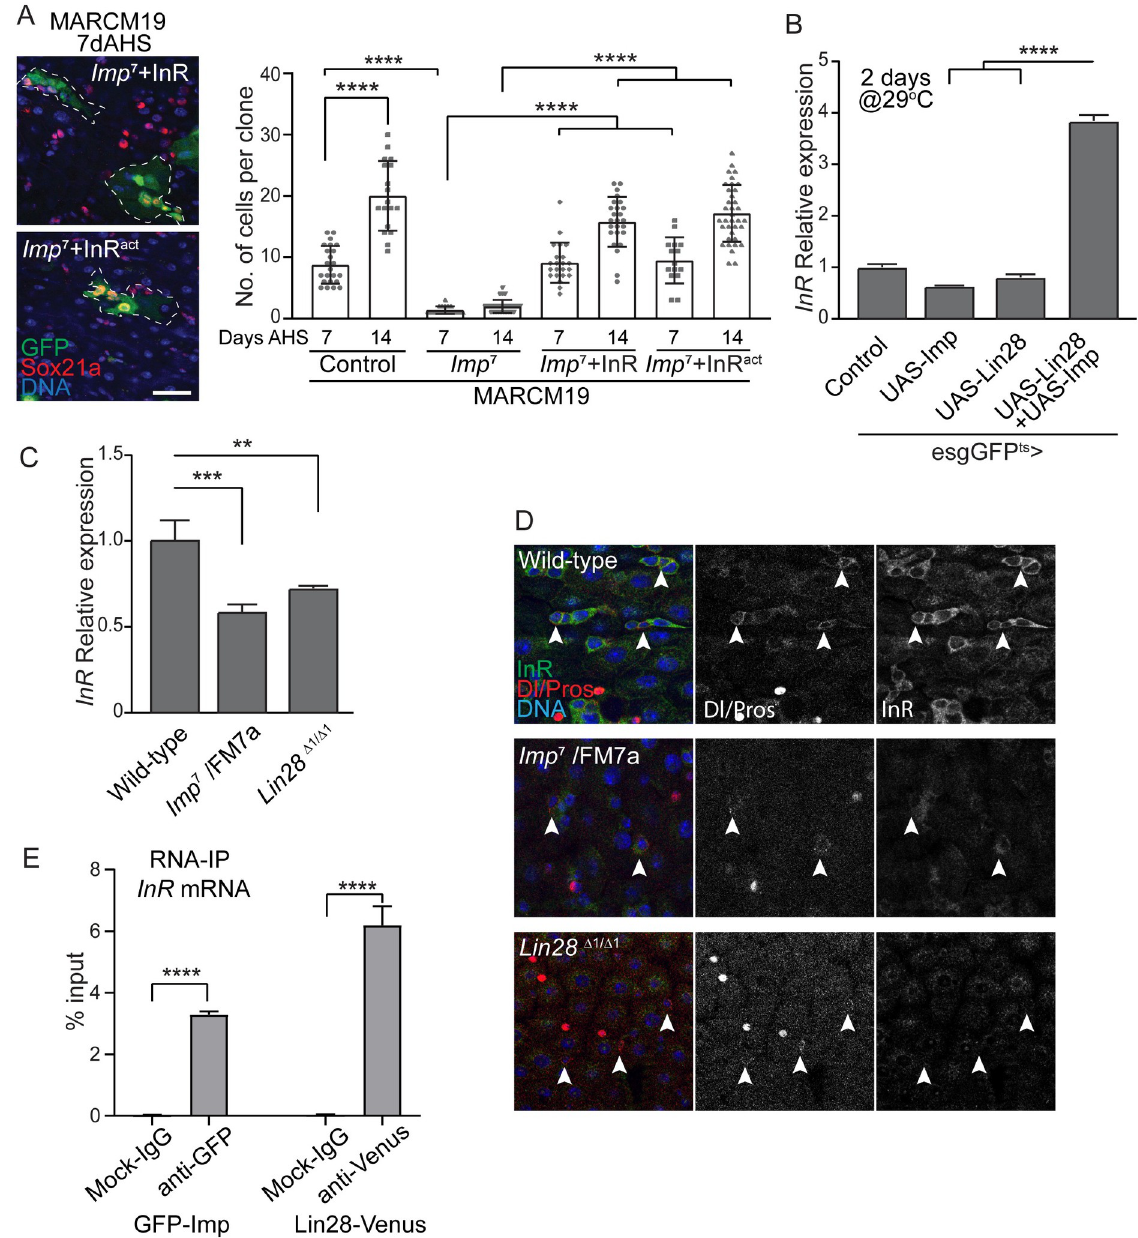
Fig 4. Imp regulates InR mRNA expression in the intestinal epithelium. (A) Confocal images of MARCM clones illustrating the growth of Imp7 homozygous mutant clones expressing wild-type and constitutive active forms of the insulin receptor (InR). GFP expression labels ISC clones, Sox21a stains for the progenitors and DNA is stained with Hoechst. The number of cells per clones in the different genetic backgrounds, 7 and 14 days after heat shock induction (AHS), are shown, demonstrating that activating InR signaling is sufficient to restore ISC proliferation in Imp mutants. Student’s t-test ���� p-value = < 0.0001 Scale bar: 10 μ m. (B) Relative expression of the InR mRNA, normalized to escargot, in the 2-day old gut from control animals and when Imp and/or Lin28 are expressed in esg-positive cells. Imp+Lin28 co-expression is sufficient to drive the expression of InR, suggesting that both proteins regulate InR synergistically. Student’s t-test ���� p- value = < 0.0001. (C) qPCR quantification of the InR mRNA, normalized to rp49, in 7-day old gut RNA extracts shows reduced InR transcript levels in Imp heterozygotes and Lin28 homozygous mutants. Student’s t-test ��� p-value = 0.0005, �� p = 0.0036. (D) Representative confocal image showing the decreased levels of InR protein detected by immunostaining (green) in intestinal progenitors of Imp and Lin28 mutants, compared to wild-type animals. Dl-positive ISCs are indicated by arrowheads. DNA is stained with Hoechst. (E) Imp and Lin28 bind to InR transcripts in adult guts. 7-day old guts were subjected to RNA-immunoprecipitation using either GFP-Imp or Lin28-venus, followed by qPCR. Significant levels of InR mRNA, normalized to input materials, are pulled down using both proteins, compared to controls. Student’s t- test ���� p-value = < 0.0001.